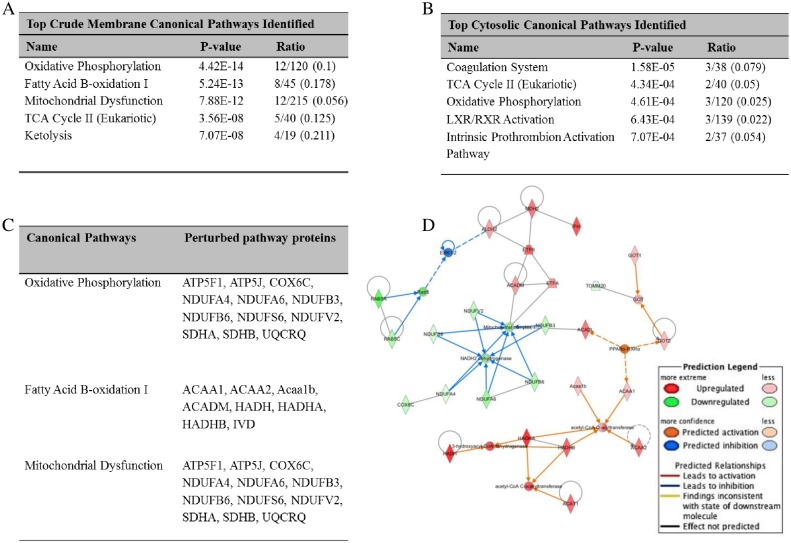
Proteomic analyses of sunitinib effects in myocardial tissue.The most significantly perturbed canonical pathways from (A) crude membrane and (B) cytosolic fractions from sunitinib treated and control mouse myocardial tissue (n = 4/group) C) Proteins perturbed in the three most significantly enriched canonical pathways. D) Ingenuity Pathway Analysis (IPA) to determine the most significantly enriched network which is centred on Mitochondrial complex 1. Colour intensity indicates the degree of up- (red) or down- (green) regulation. IPA predictions are shown in blue (predicted inhibition) and orange (predicted activation). Black indicates no predicted effect. Continuous lines indicate a direct relationship between two proteins; a discontinuous line indicates indirect association.